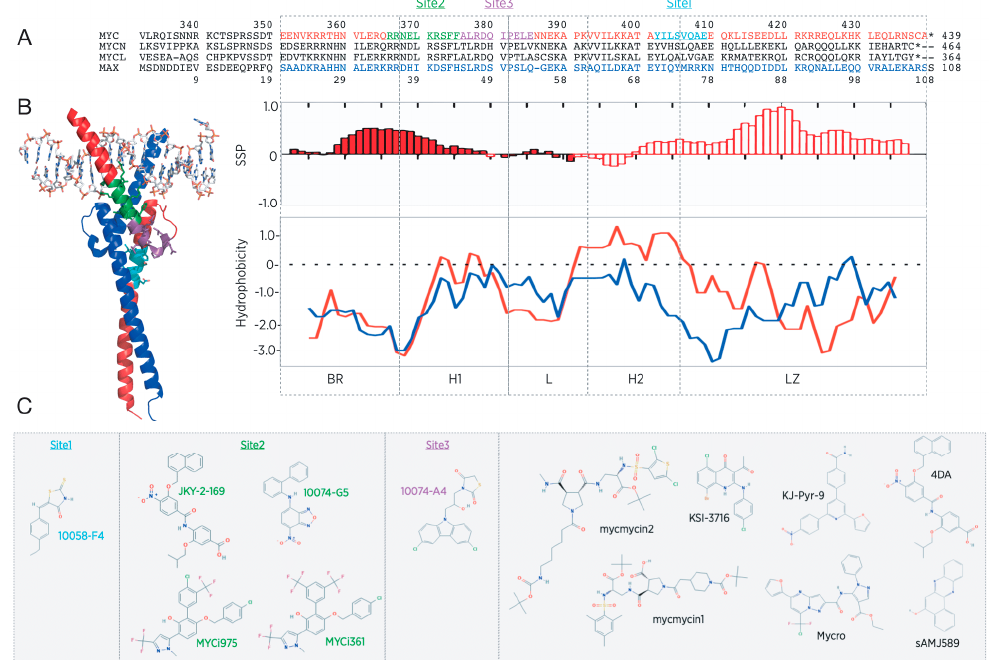
Figure 5. ( A ). Top: Sequence alignment of MYC (red), MYCN, MYCL, and MAX (blue). The binding sites for small molecules (SM) are identified: Site I in cyan, Site II in green and Site III in purple. The secondary structure prediction (SSP) for the MYC bHLHLZ in absence of MAX and of DNA is shown (adapted from Panova et al. [55]): Positive values correspond to helix and negative values indicate β –strand or polyproline II helix (PPII). Filled bars indicate predictions from the measured chemical shifts, while open bars refer to predictions based on signal broadening. Below, the hydrophobicity of the MYC (red) and MAX (blue) polypeptides as calculated from ProtScale using the Kyte and Doolittle reference values (https: // web.expasy.org / protscale / pscale / Hphob.Doolittle.html). ( B ). Crystal structure of the DNA-bound MYC / MAX heterodimer (1NKP.pdb) highlighting the binding sites for SM (the same color code as in A is used). ( C ). Two-dimensional structure of the SM MYC inhibitors mentioned in the manuscript. The SM inhibitors binding to Site I, Site II or Site III are